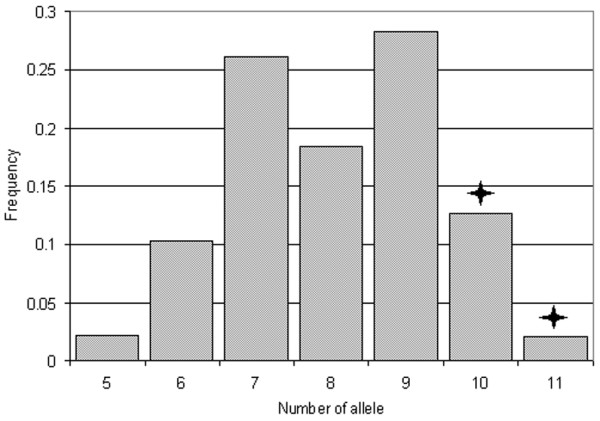
Allele frequencies of tetranucleotide repeat short tandem repeat marker M06NR1A. The strongest signals of association with hand osteoarthritis were obtained with alleles 10 and 11 (marked by star symbols).